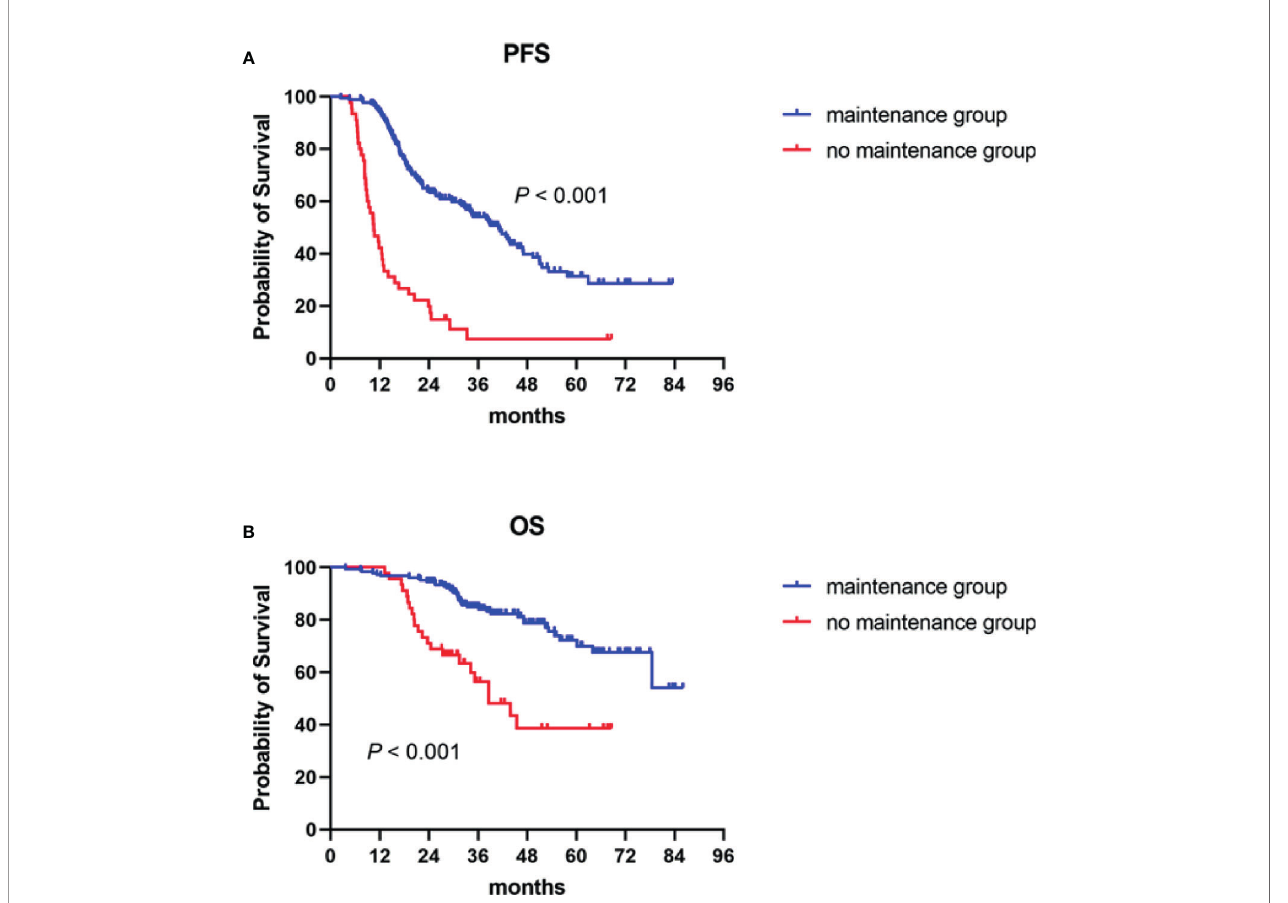
FIGURE 1 | Progression-free (PFS) and overall survival (OS) in NDMM patients with or without maintenance therapy. Kaplan – Meier curves are shown for (A) PFS and (B)